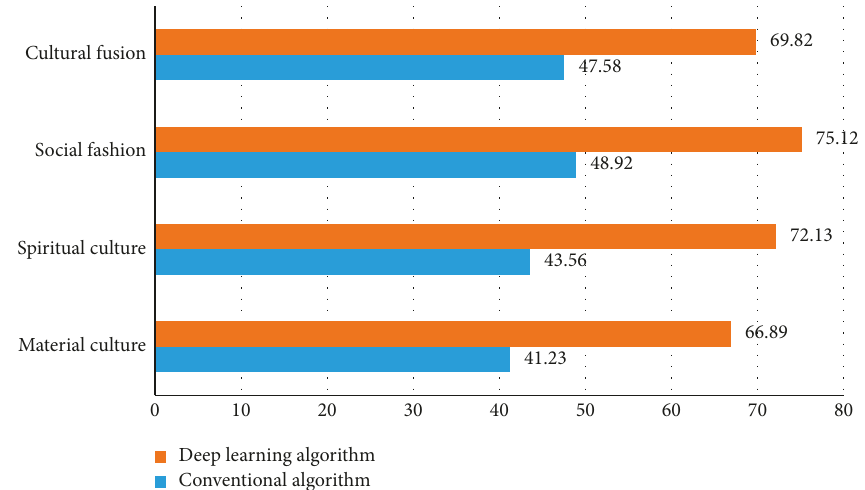
Figure 3: Visual analysis of the Dunhuang murals and modern costumes under different Table 2: Comparison of the influence of clothing and culture in different periods.